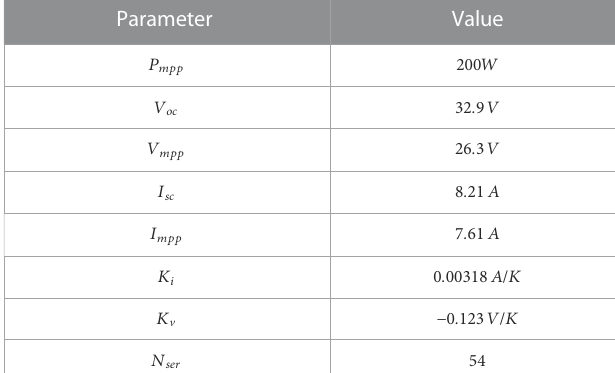
TABLE 1 Datasheet parameters of the KC200GT PV module at STC conditions. Parameter